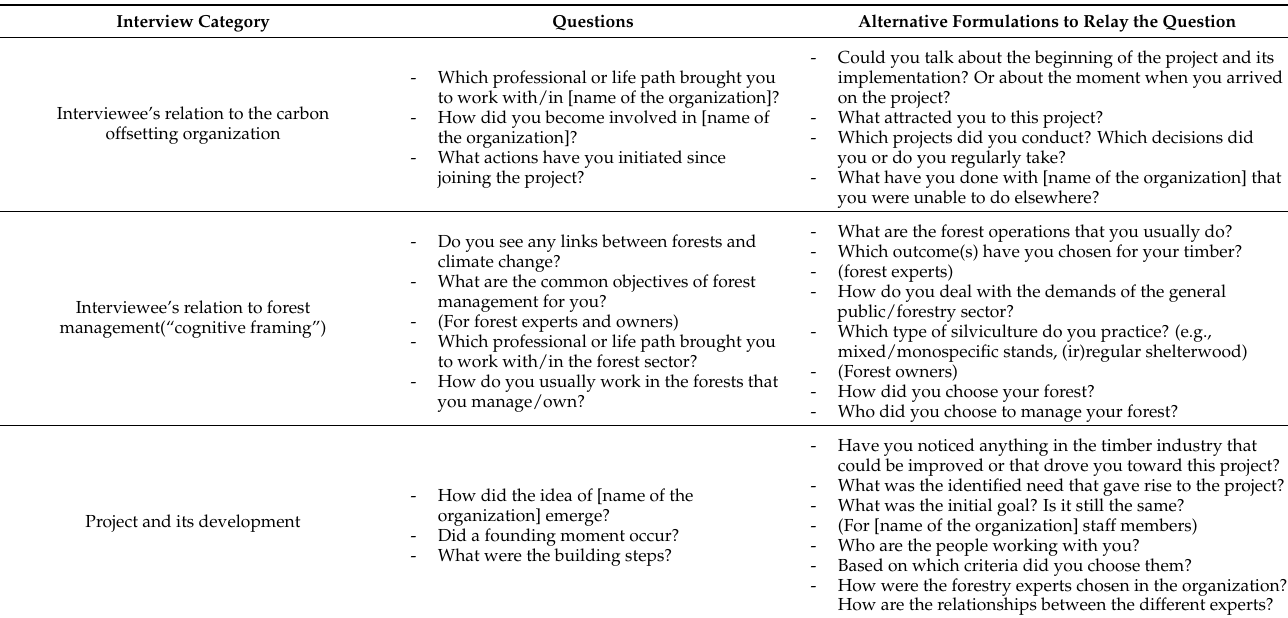
Table A3. Grid of the semi-directed